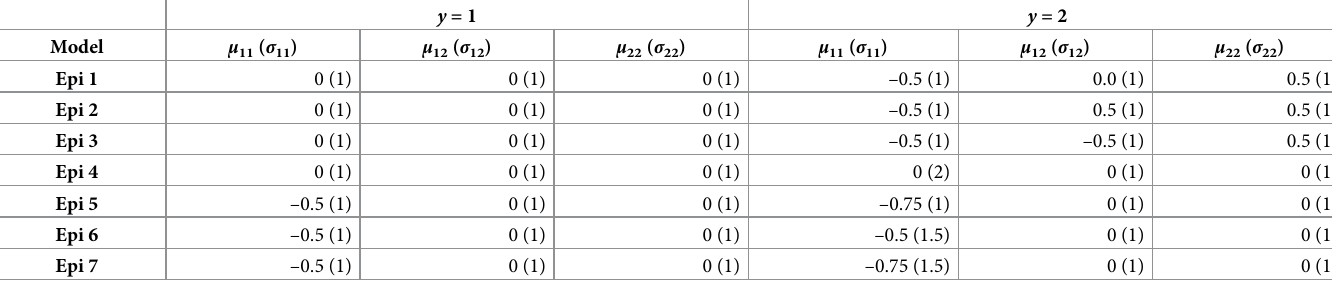
Models are shown on the standard normal scale. For each replicate, the proportion α of individuals with y = 2 is drawn from a N (0.7, 0.1) distribution; for all models, a value of y = 2 also adds 3 years on average to the mean time-of-event relative to y = 1, regardless of